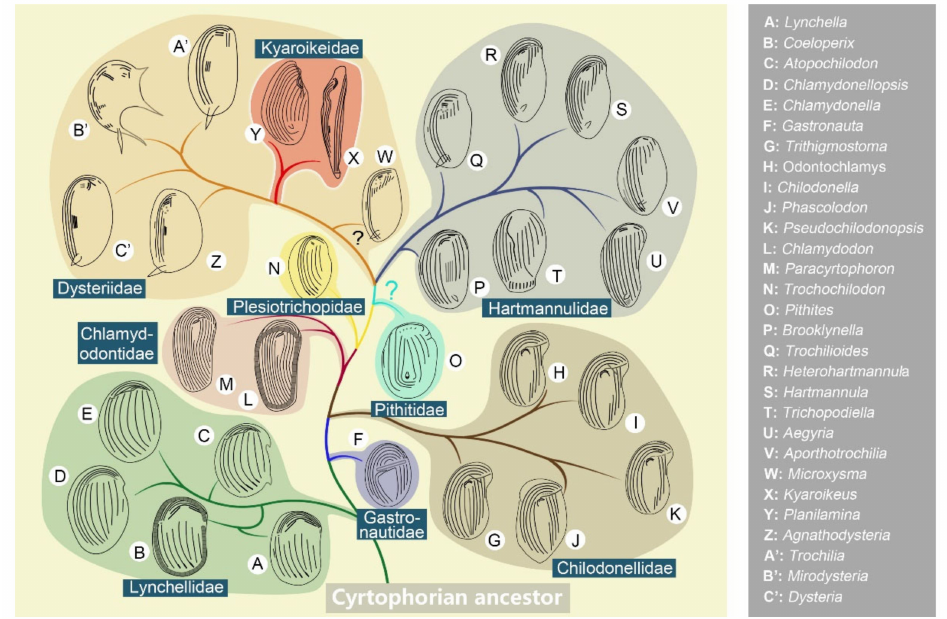
Figure 6. Evolutionary pattern of the subclass Cyrtophoria inferred from species with both morpho- logical and molecular data. All illustrations are